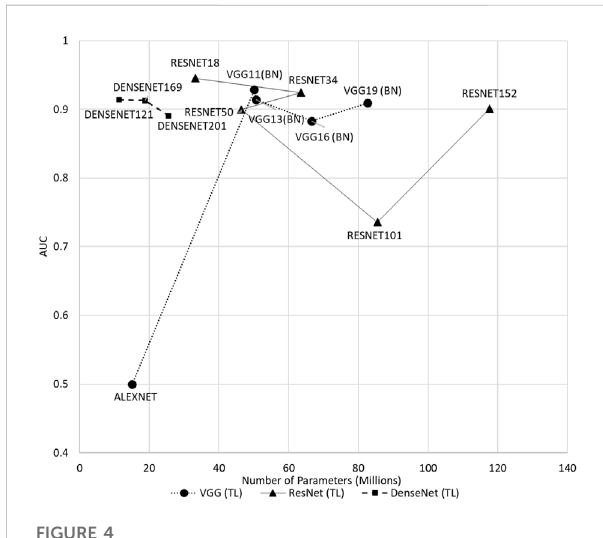
FIGURE 4 Comparison of all transfer learning-based models in terms of